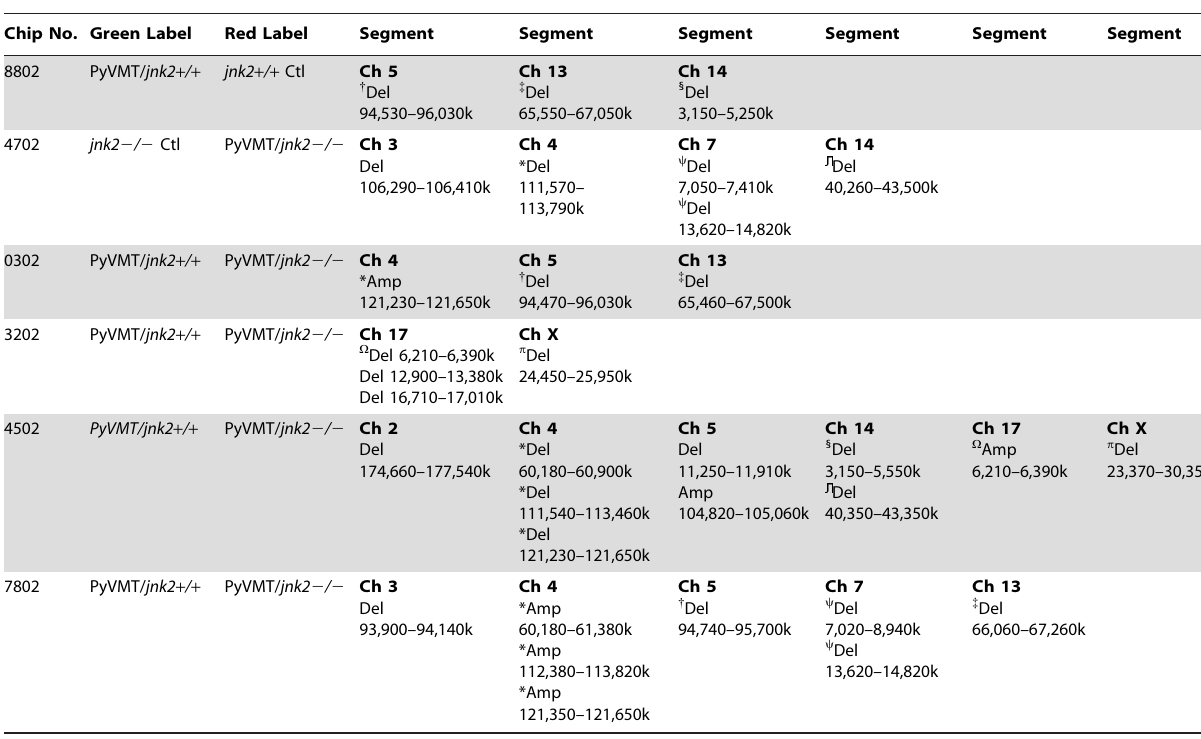
Chip No. Green Label